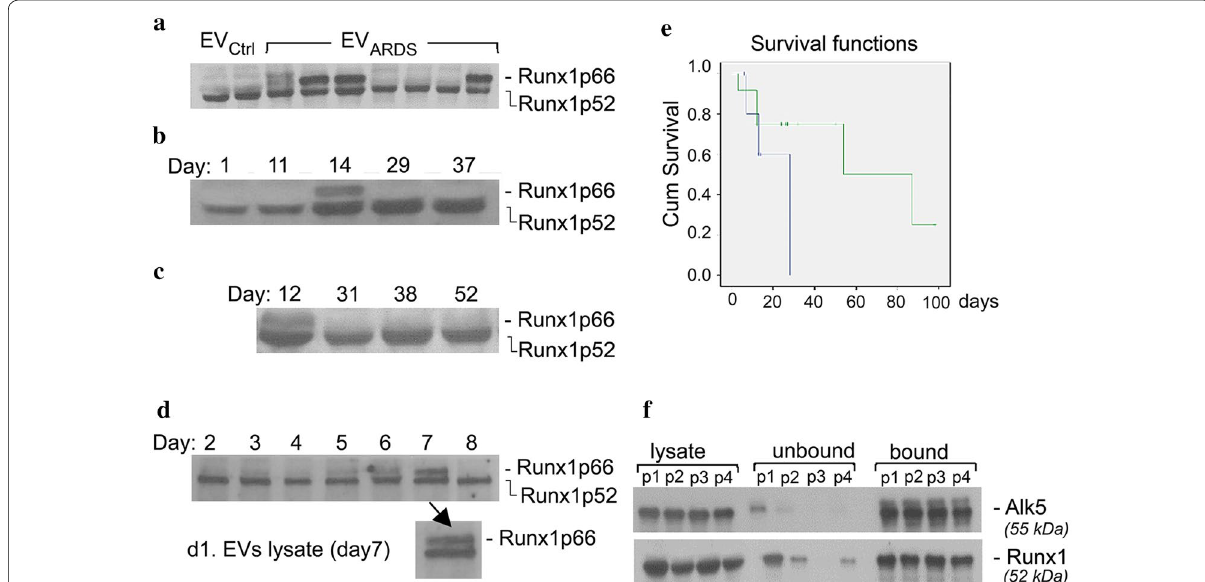
Fig. 4 Runx1p66 protein expression is short-lived and provides a survival advantage. a Representative Western blot of Runx1 protein expression in seven EV ARDS and two EV Ctrl preparations. Normalization was achieved to the volume of blood used (typically 1.5 ml) for EVs isolation. b Time course analysis of Runx1 in EV ARDS of a long-term ARDS survivor (S6) and panel c , a non-surviving ARDS patient (S12). Expression of Runx1p52 gradually increases from day 1 to day 37 in ICU in the EV ARDS of long-term survivor. Even if the number of blood samples available for later time points assessed was lower due to death of some patients, the time course analysis data are representative for at least three long-term survivors and three non-surviving ARDS patients. d Western blot of Runx1 expression in lysates of cultured human bone marrow-derived MSCs (d2–d8) as well as in lysates of the EV MSC released at d7 (d1). 30 μg protein/lane; n 3. e The Kaplan–Meier statistic shows the improved survival for = the EV ARDS Alk5Runx1p66 patients. Out of 33 ARDS patients included in the study, only 29 patients (multiple samples) were used to investigate the Runx1 isoform content and the Runxp66/p52 ratio. f Four EV ARDS preparations (p1–p4; isolated from 1.8 ml of blood) were labeled with a